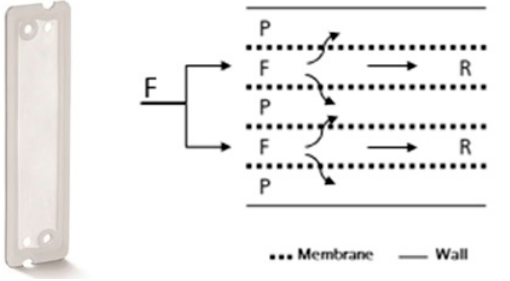
Figure 3. Membrane separator with an increased membrane area (200 cm 2 ). Front view ( left ); schematic presentation of the feed (F), retentate (R) and permeate (P) channels ( right ).